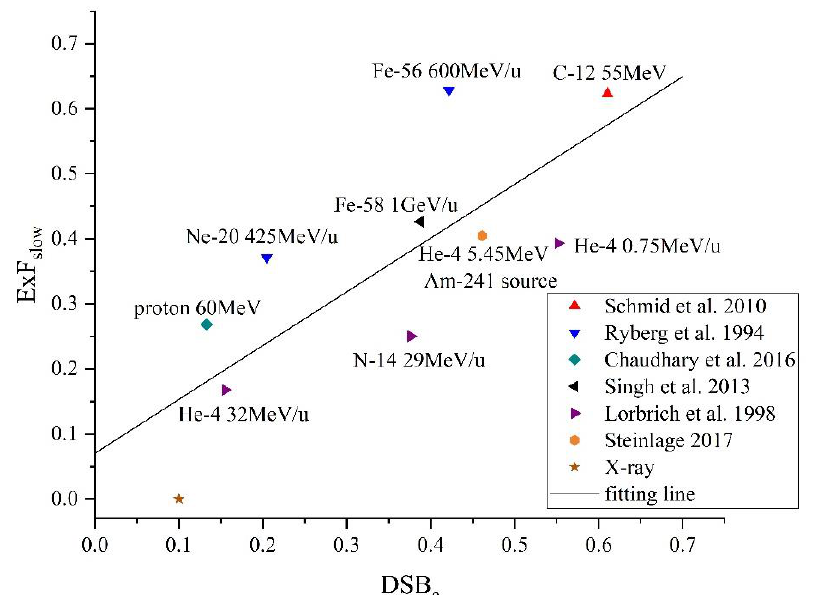
Figure 2. Data and the fitting line of complex DSBs (DSBc) and additional fractions of the slow compartment attributed to complex DSBs (ExF slow ) [17,29 – 31].